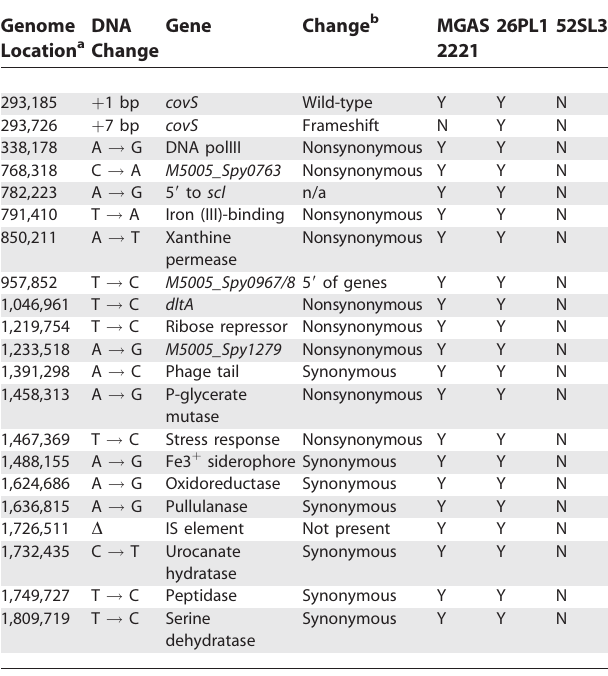
Table 1. Genomic Differences Differentiating MGAS5005 from the Isolates MGAS2221, 26PL1, and 52SL3 Genome DNA Location a Change